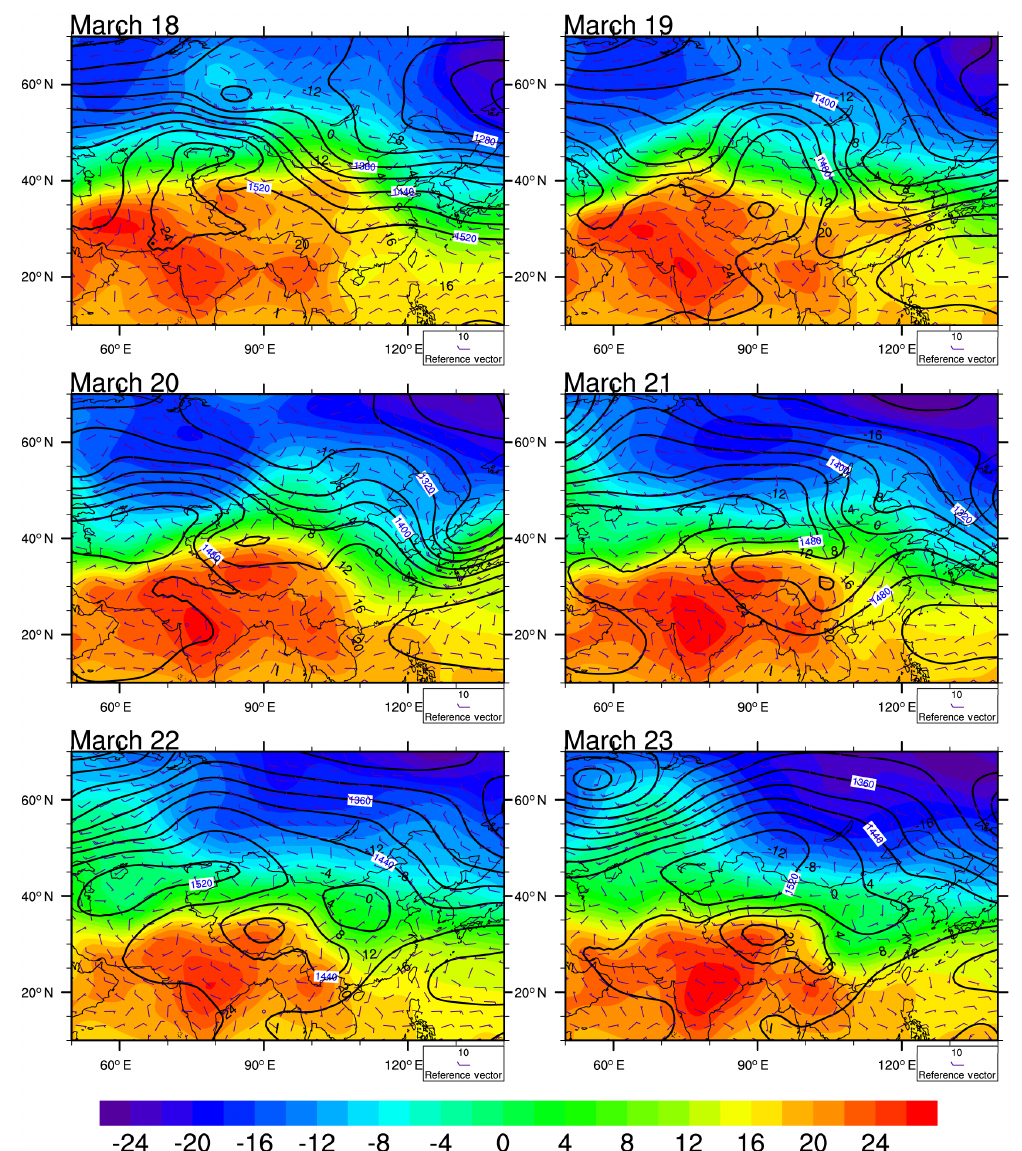
Figure 8. Spatial distributions of the geopotential height (blue lines, unit: gpm) and temperature (color, unit: ◦ ) at 850hPa from the NCEP/FNL reanalysis data over East Asia during the simulation period. The vectors represent the wind field at 850hPa (m × s − 1 )